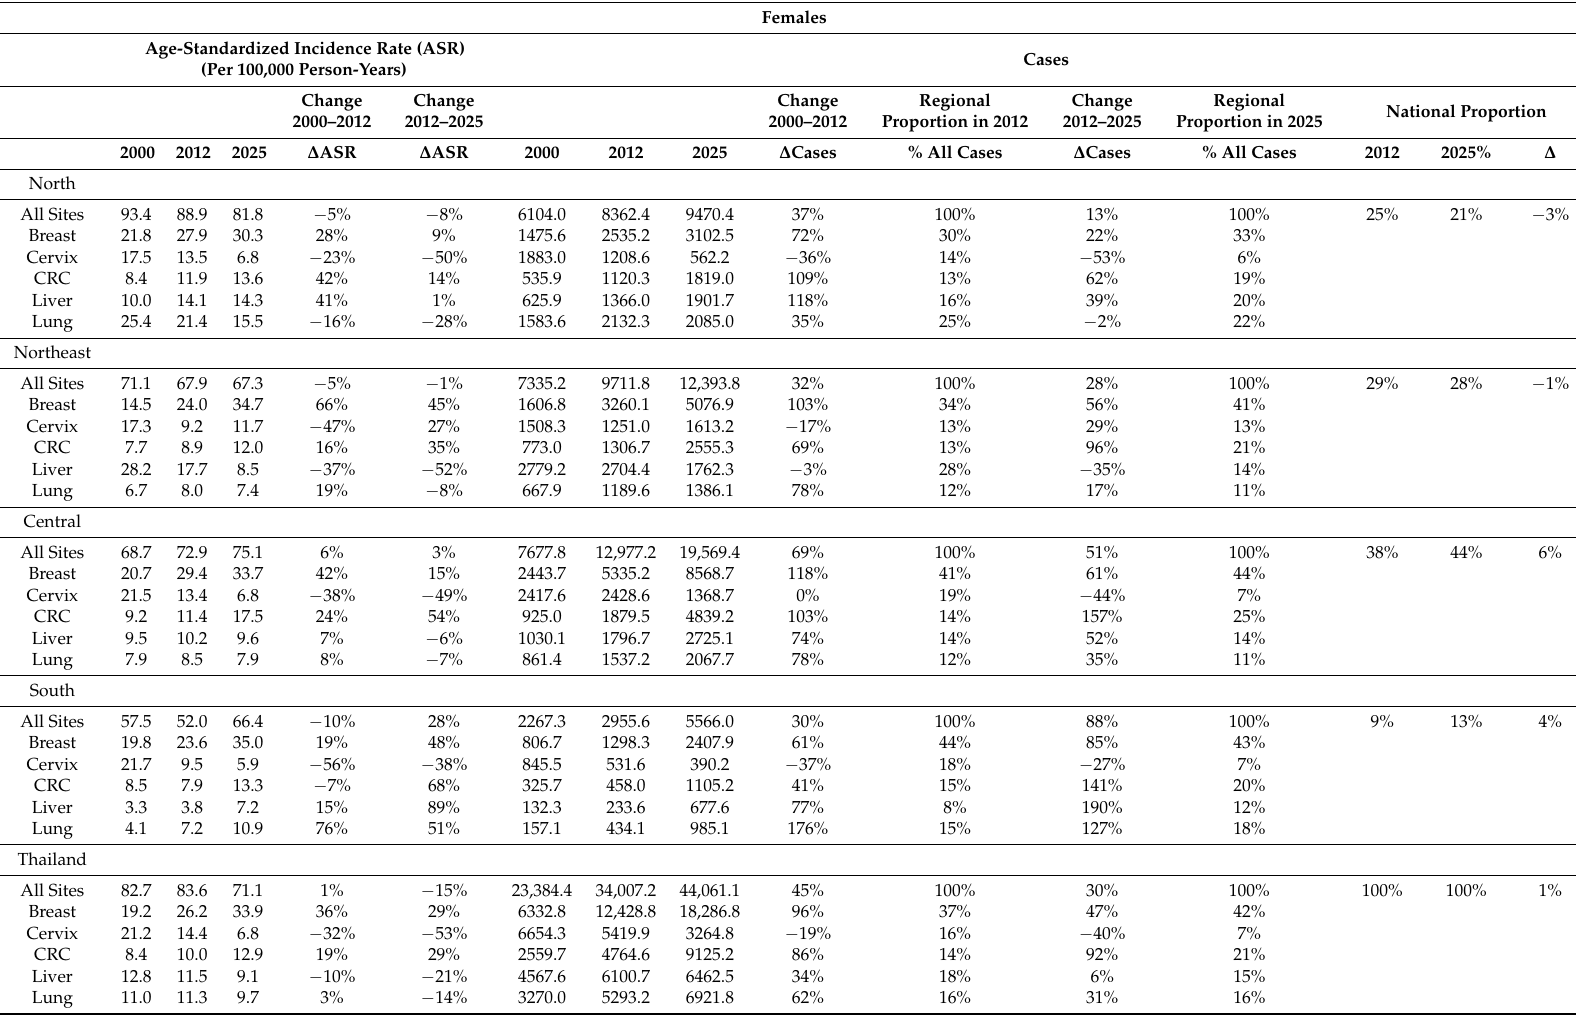
Table 1. Subnational and National Age-standardized Incidence Rates for Cancers and Estimated New Cases, 2025, by Region.